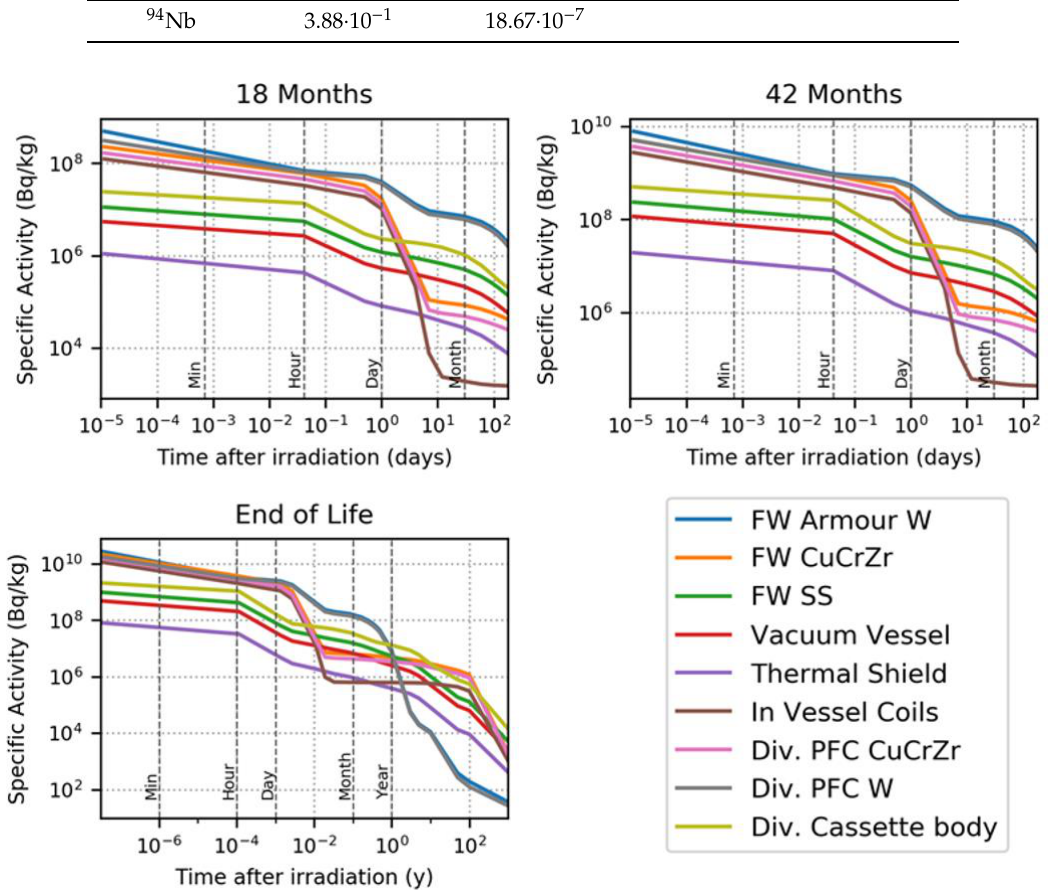
Figure 3. Activating DTT in-vessel components.